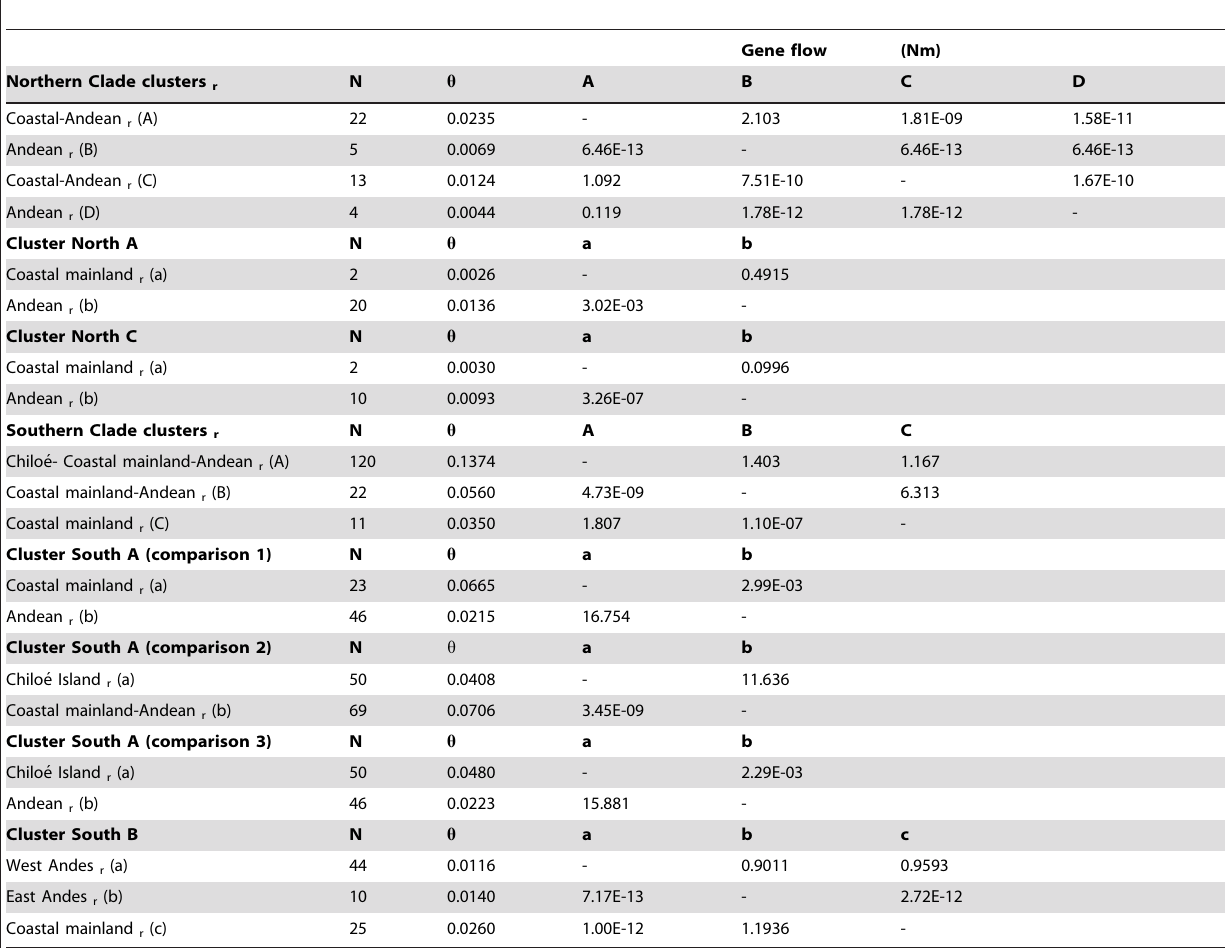
Table 3. Results of H and migration rate between clusters of population of L. pictus . Clusters correspond to the same already defined by Geneland.